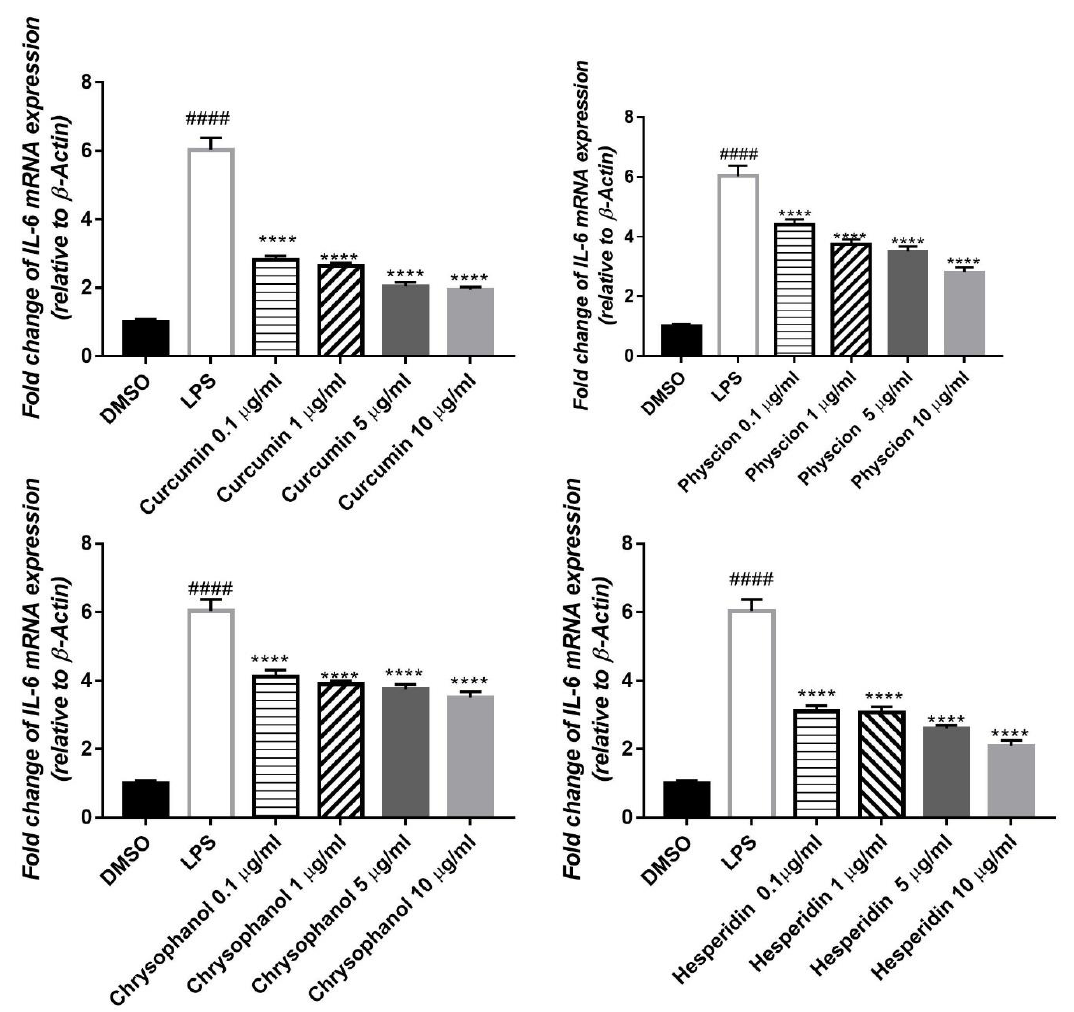
Figure 5. Effects of isolated compounds (1–4) on the elevated level of IL-6 expression induced by 1 µg/mL LPS in HepG2, relative to β-Actin. qPCR was used for detection of mRNA expression. Results are shown as ± S. E ( n = 3), #### p < 0.0001 compared with control. **** p < 0.0001 compared to LPS.